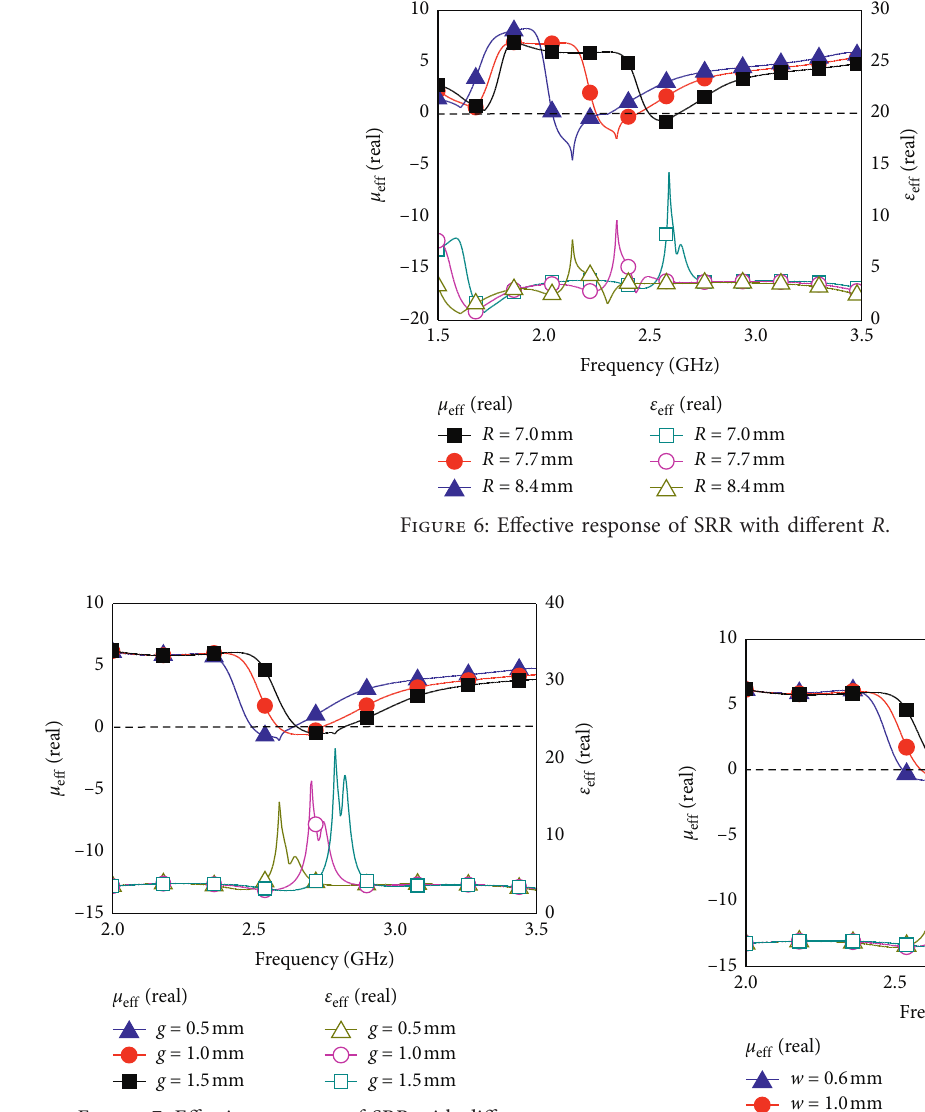
Figure 7: Effective response of SRR with different g .